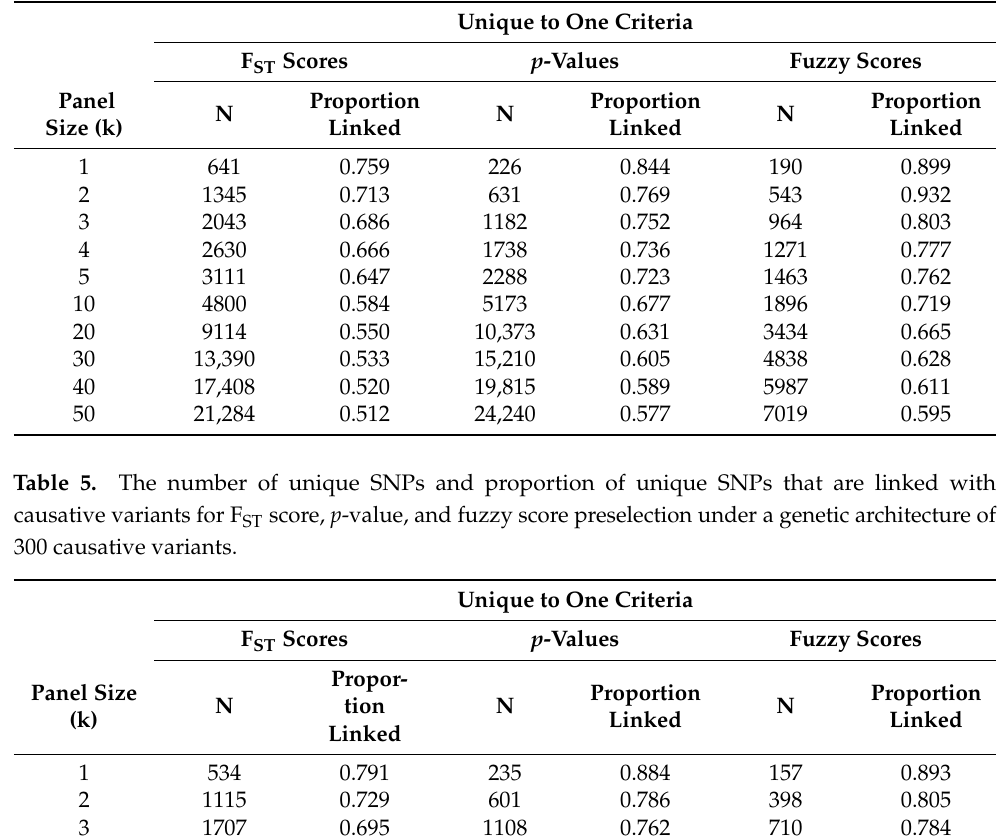
Table 4. The number of unique SNPs and proportion of unique SNPs that are linked with causative variants for F ST score, p -value, and fuzzy score preselection under a genetic architecture of 1 k causative variants.